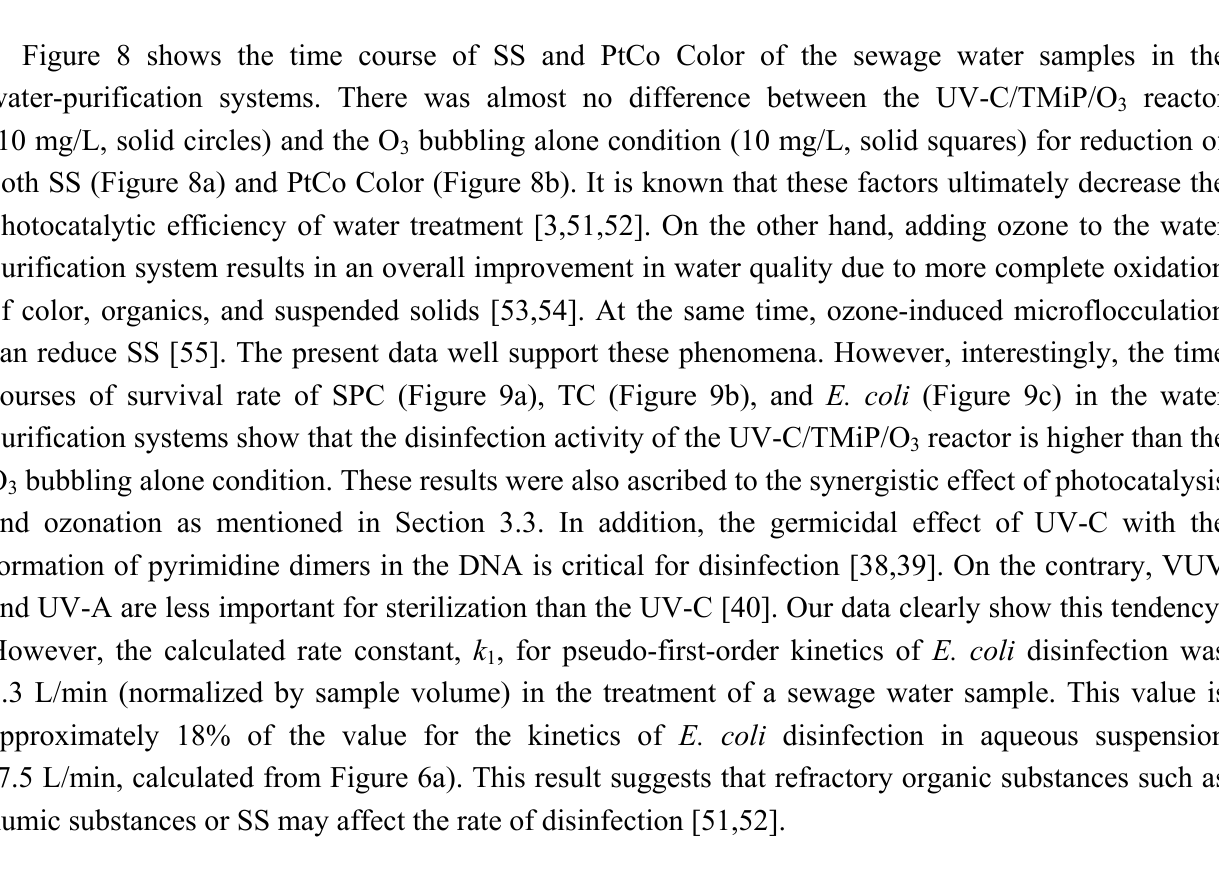
Figure 8. Time course of ( a ) SS and ( b ) PtCo Color of the sewage water in the water-purification system. solid squares: O UV-C/TMiP/O reactor (10 3